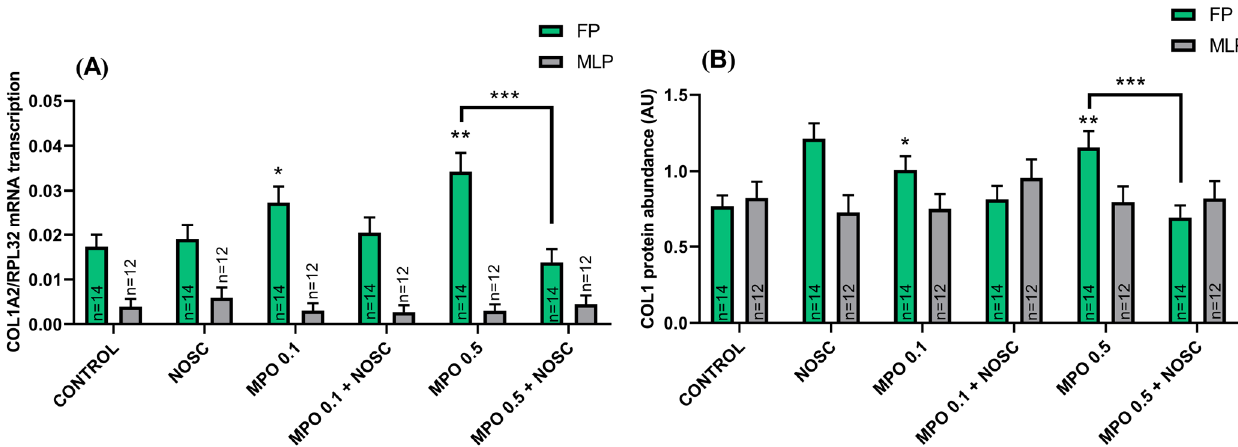
Figure 3. Effect of myeloperoxidase (MPO; 0.1–0.5 μg/mL), noscapine (NOSC; 45 μg/mL), or MPO MPO (0.1–0.5 µ g/mL) + NOSC (45 µ g/mL) treatments on relative collagen type I alpha 2 (0.1–0.5 μg/mL) + NOSC (45 μg/mL) treatments on relative collagen type I alpha 2 chain ( COL1A2 )